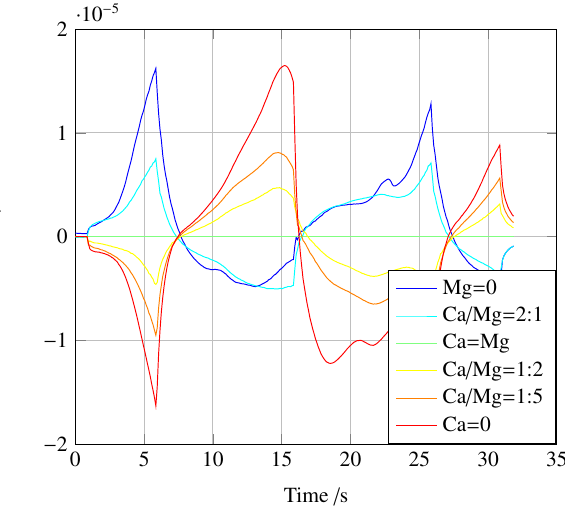
Figure 10. Relaxation time depending on calcium-magnesium- ratio.